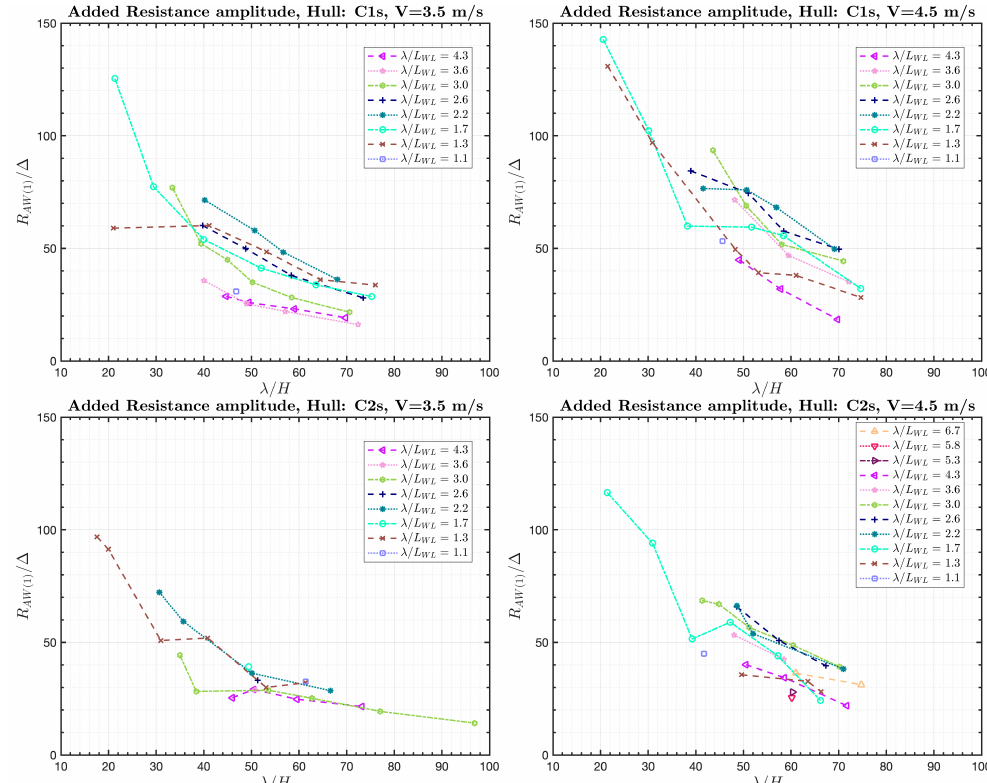
Figure 10. Added resistance first harmonic amplitude vs. λ / H .